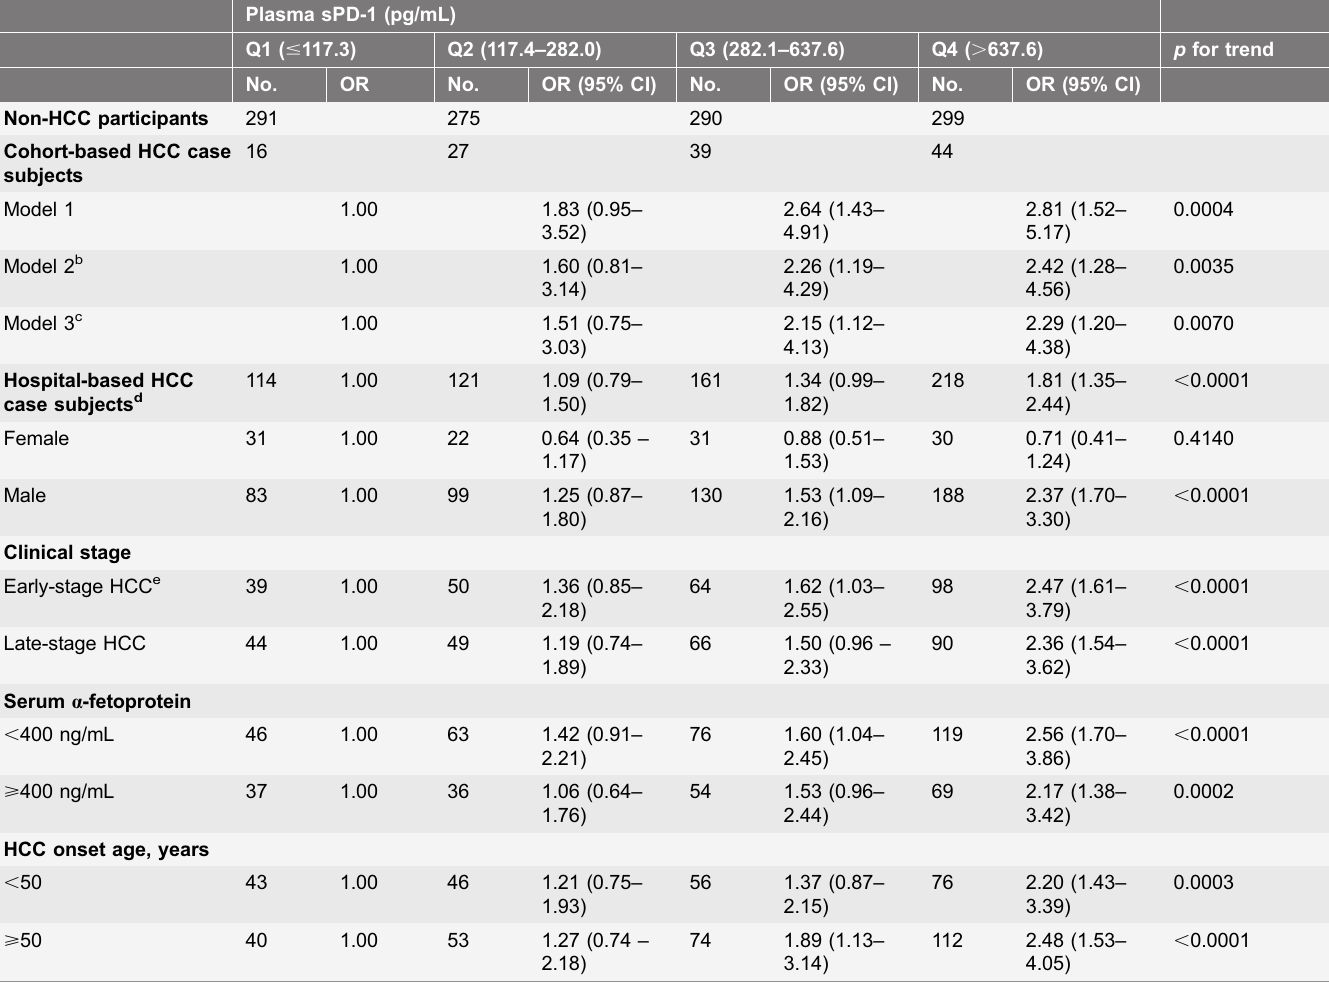
Table 2. Risk of hepatocellular carcinoma (HCC) by quartile (Q) of plasma sPD-1 levels: case-cohort and case-control studies a